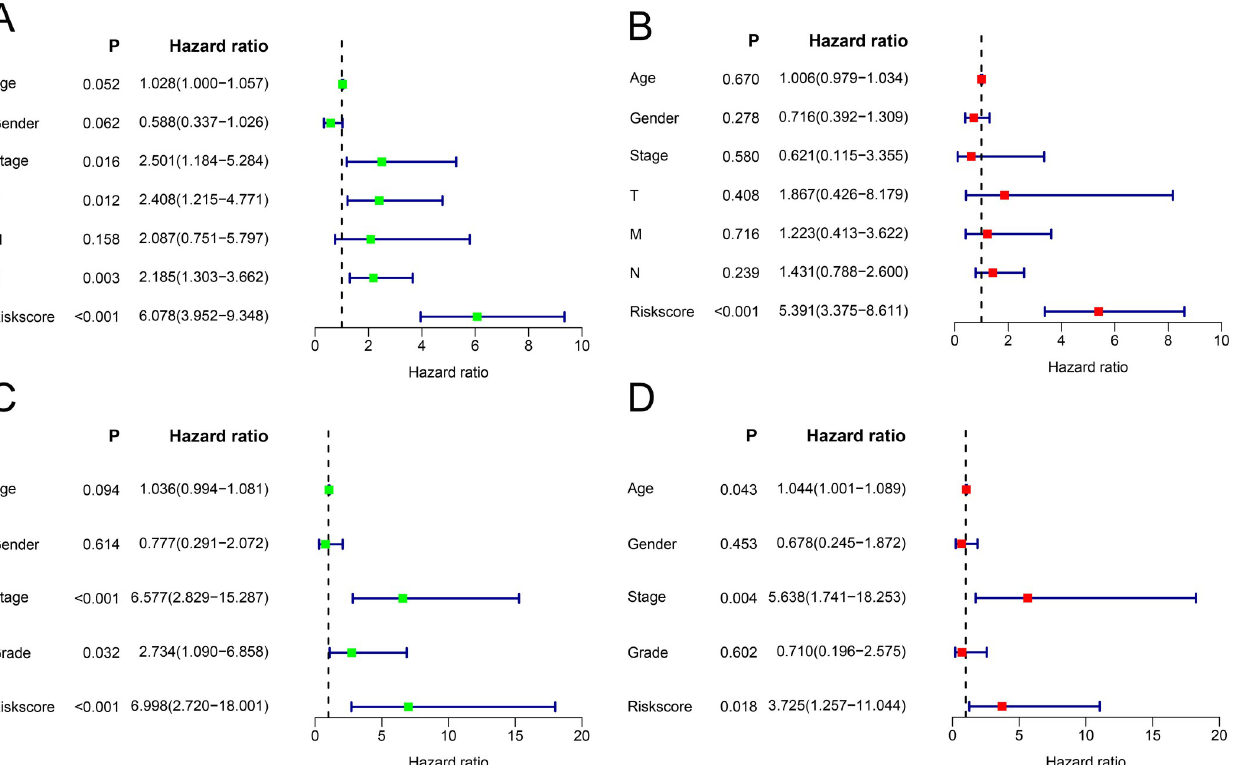
Fig 3. Independent prognostic analysis of the risk score. In the TCGA cohort, the results of univariate (A) and multivariate Cox analyses (B) showed that the risk score could be used as an independent prognostic factor for BC. In the GEO cohort, the results of univariate (C) and multivariate Cox analyses (D) also showed that the risk score could be used as an independent prognostic factor for BC. TCGA, The Cancer Genome Atlas; GEO, Gene Expression Omnibus; BC, bladder